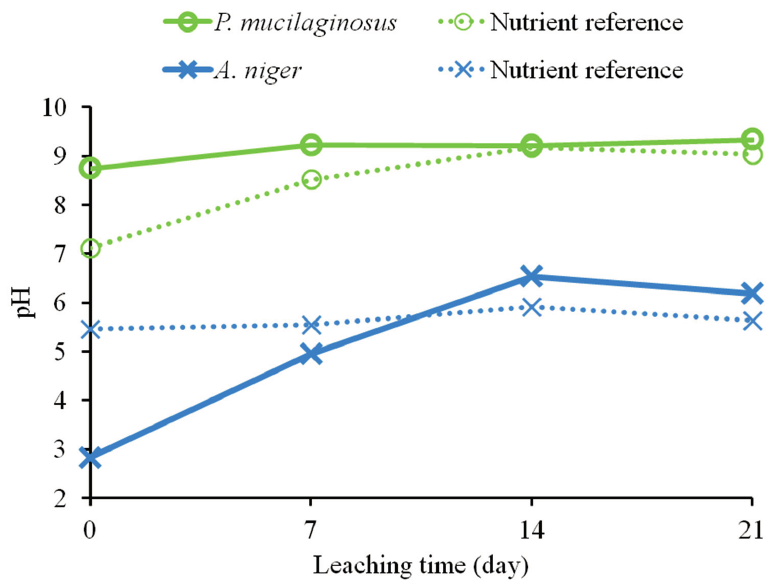
Figure 2. Variation of pH, measured weekly, during bioleaching of fresh olivine over 21 days by Aspergillus niger and Paenibacillus mucilaginosus and their respective nutrient broth